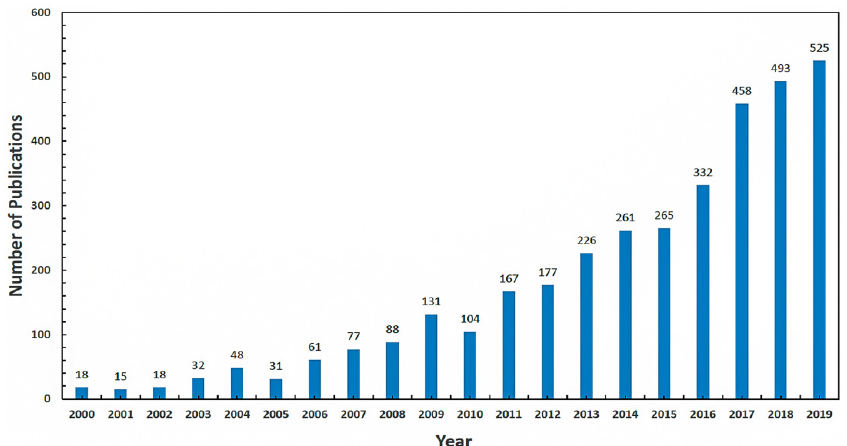
Figure 1. Papers on rehabilitation robots published per year from 2000 to 2019 indexed in WoS.